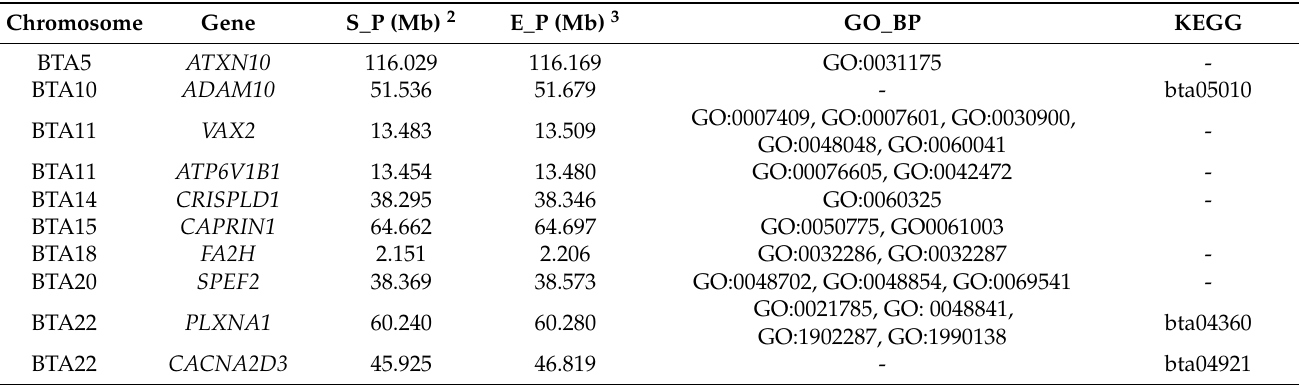
Table 3. Gene ontology biological terms (GO_BP) and metabolic pathways from the Kyoto Encyclo- pedia of Genes and Genomes (KEGG) access of genes overlapped by top 0.001% markers for docility in American Angus cattle 1